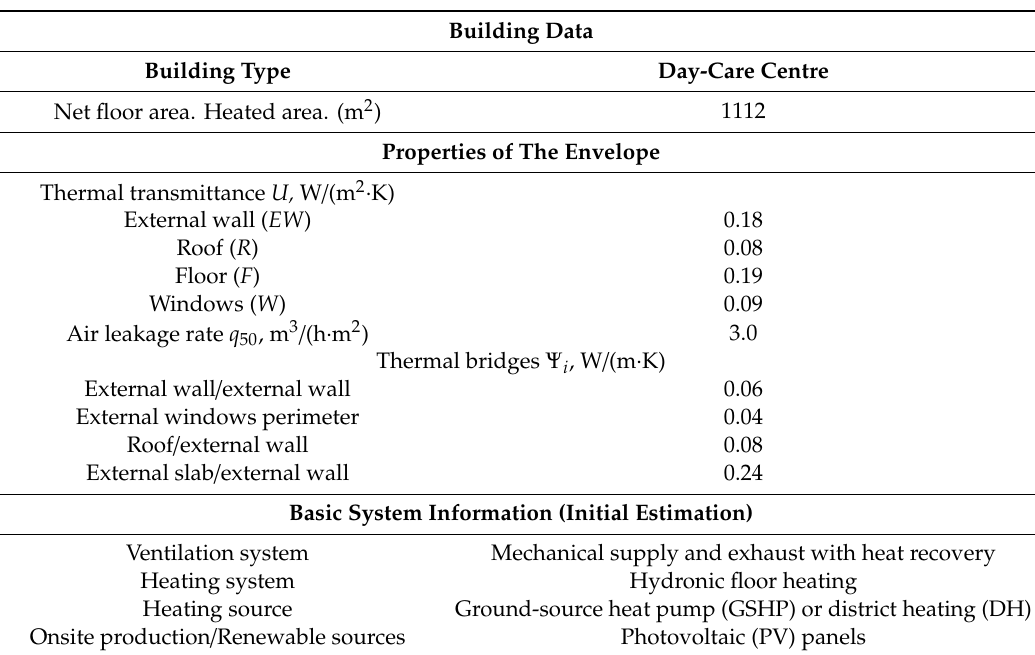
Figure 1. ( a ) plan of the case study building; ( b ) front view of the case study building. Figure 1. ( a ) Plan of the case study building; ( b ) front view of the case study building. Table 1. Technical information of the Table 1. Technical information of the building.